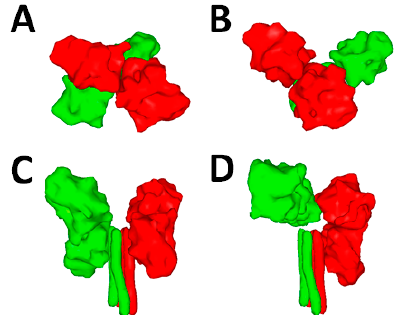
Figure 2. Possible structure(s) of the MeV attachment protein. ( A and B ) Crystal structures of MeV H in complex with the receptor signaling lymphocyte activation molecule (SLAM) (not shown). Two tetrameric configurations were determined (PDB 3ALZ and 3ALX). High ‐ resolution structures were morphed into low ‐ resolution images using the Sculptor software package; ( C and D ) Two alternative folds of H tetramers. Images were obtained from homology models performed with the canine distemper virus CDV) H sequence (strain A75/17) and based on the atomic coordinates of Newcastle disease virus (NDV) HN (PDB 3T1E) and hPIV5 HN (PDB 4JF7). The dimers of the attachment protein tetramer are color ‐ coded in green and red.